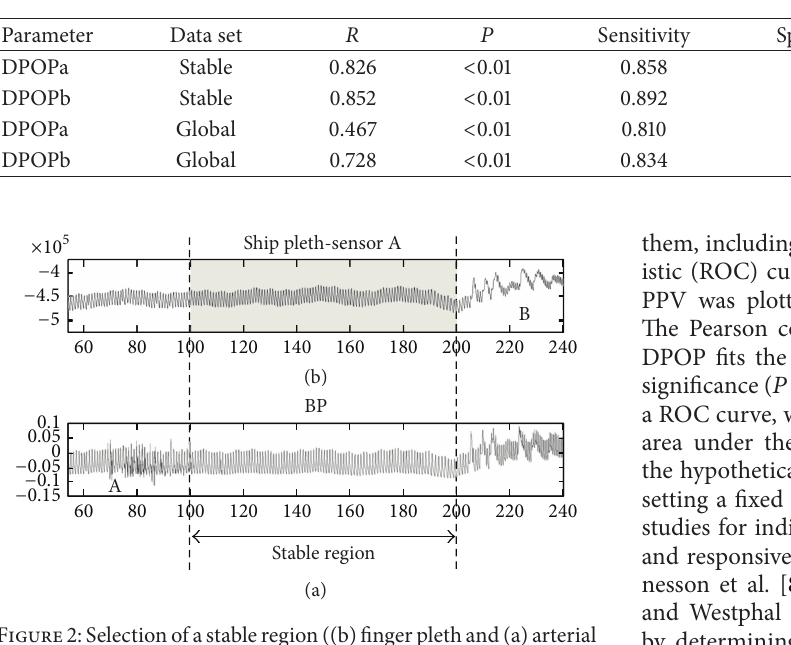
Table 1: Original and PMod corrected DPOP results.